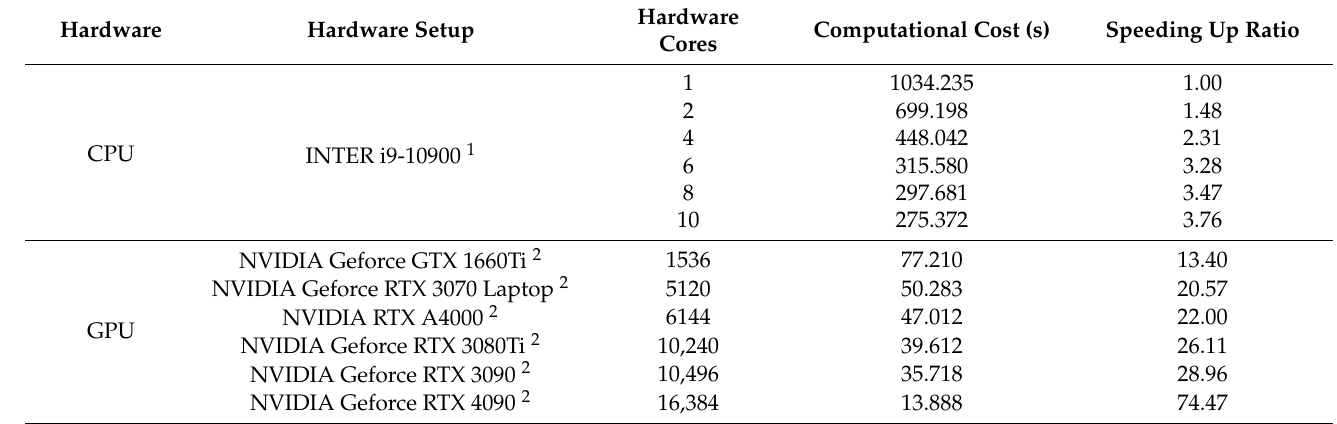
Table 3. Hardware configurations and computational cost for the Malpasset dam